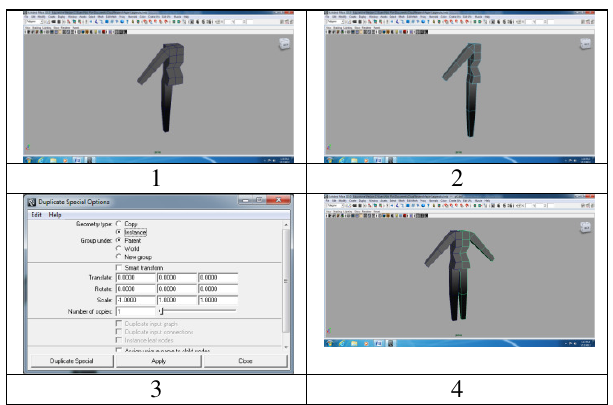
Figure 18. An Example of the Mirror